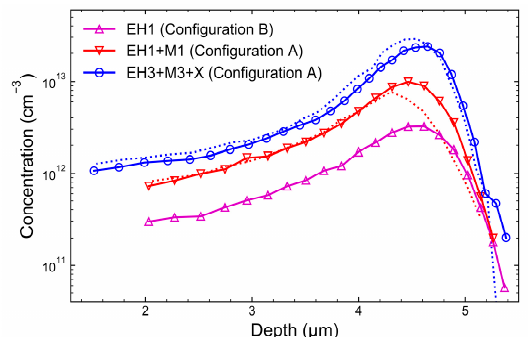
Figure 10. EH1, EH1 and M1, and EH3 and M3 depth concentration profiles in 7.5 MeV C (10 8 cm − 2 ) ion implanted SBD. The shown EH1 + M1 concentration profile (Configuration A) was measured after cooling SBD from 340 K down to 210 K under − 30 V bias, while EH1 profile was measured after cooling down SBD from 450 K without bias. Depth profiles measured before 450 K annealing (as seen in Figure 6) are shown with dotted lines.